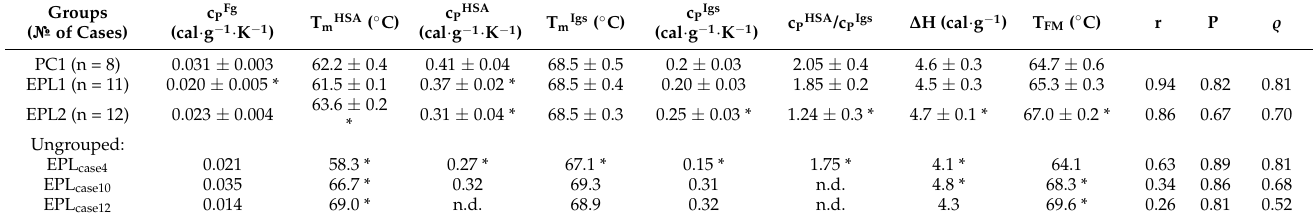
* Indicates statistically significant difference ( p < 0.05) from the respective PC1 control value; n.d. –not